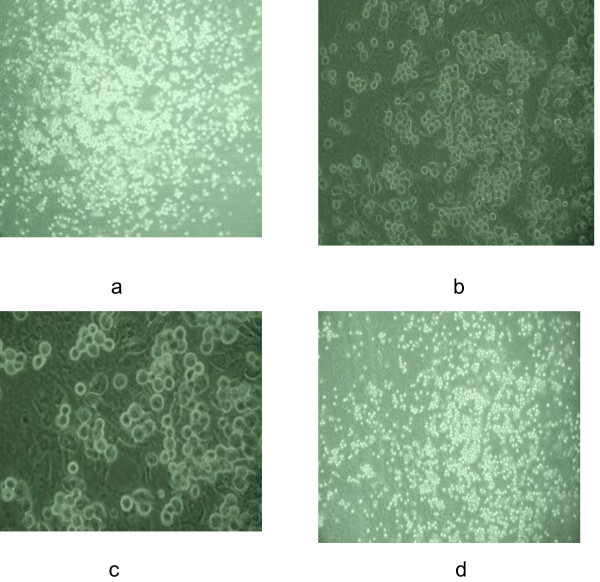
SSCs observed under inverted phase contrast microscope at different times. a, b, c: SSCs at 48 h of culture on the feeder layer of Sertoli cells (×100, ×200, ×400, respectively); d: SSCs at 30 days of culture on the feeder layer of Sertoli cells (×100).